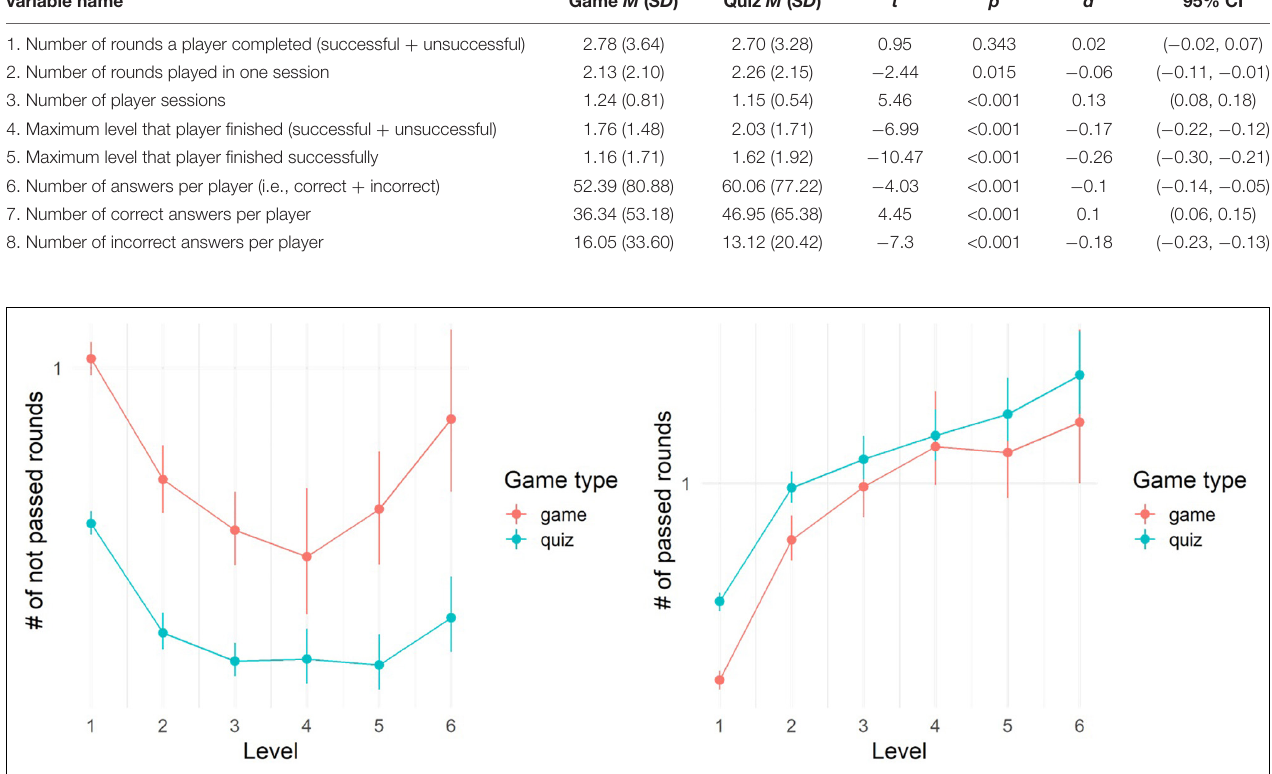
FIGURE 3 | Mean number of not passed rounds per player and level (left) and passed rounds per player and level (right). Note that a player can return to the level and play it several times. Error bars indicate bootstrap-based 95%-confidence intervals.